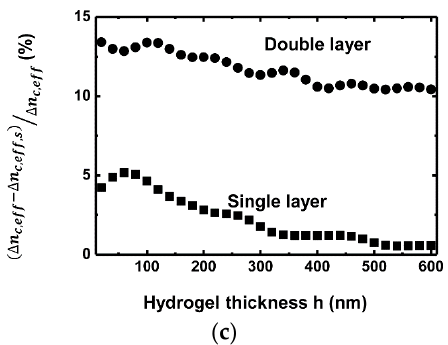
Figure 4. ( a ) Waveguide effective RI 𝑛 𝑐,𝑒𝑓𝑓 for various hydrogel thicknesses (dotted curve: before functionalization, solid curve: after functionalization using a double-layer model ( 𝑛 ℎ,𝑢𝑝 = 1.39, 𝑛 ℎ = 1.34), dashed curve: after functionalization using a single-layer model ( 𝑛 ℎ,𝑠 = 1.35)) and ( b ) effective RI change 𝑛 𝑐,𝑒𝑓𝑓 for various hydrogel thicknesses (solid curve: double-layer model ( 𝑛 ℎ,𝑢𝑝 = 1.39, 𝑛 ℎ = 1.34), dashed curve: single-layer model ( 𝑛 ℎ,𝑢𝑝 = 1.35)). The functional volume ratio 𝑎 is 0.2 for the double-layer model. The black and gray curves represent the cases with and without considering hydrogel shrinkage after deswelling. Shrinkages of 2% and 10% in thickness are assumed for a single- and double-layer model, respectively. ( c ) Effect of the hydrogel shrinkage on the waveguide effective RI change for single- and double-layer models.